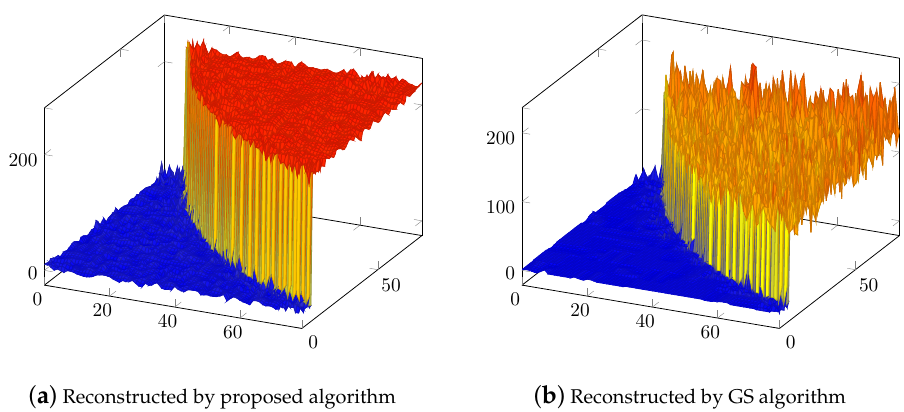
Figure 8. Three-dimensional intensity profiles for the “circle” reconstructed image obtained by ( a ) the proposed algorithm and ( b ) the GS algorithm